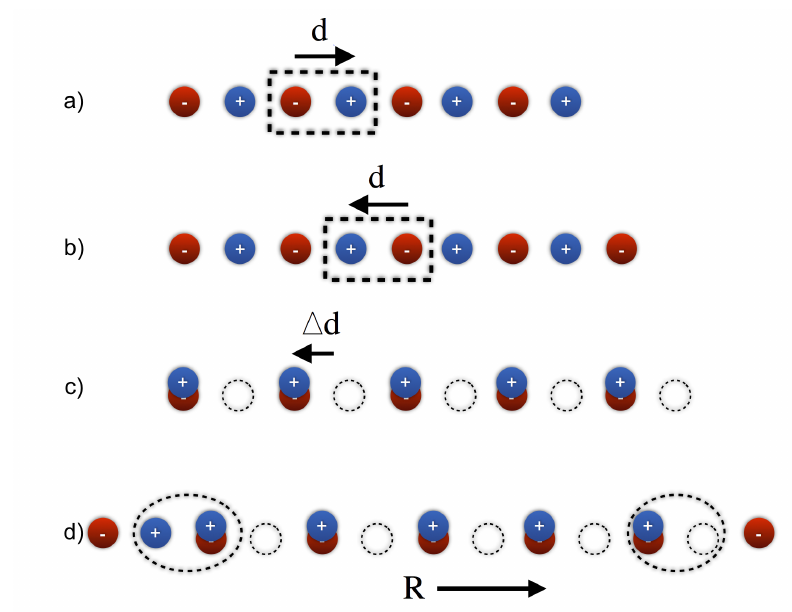
Figure 3: Polarization in a 1D inversion symmetric lattice. a) One choice of micro- scopic dipole d in the Type I lattice. b) Another choice of d that results in completely opposite polarization vector. c) A Type II lattice is the other possibility for an inver- sion symmetric lattice. The change in the microscopic dipole is ∆ d . Here the idea is that positive and negative charges are sharing the same lattice site. They are shown as slightly displaced for illustration purposes. d) Sandwiching a Type II lattice be- tween sections of a Type I lattice gives charges of ± e at the interfaces, which one can 2 see by allowing the point charges to be blurred out a bit in